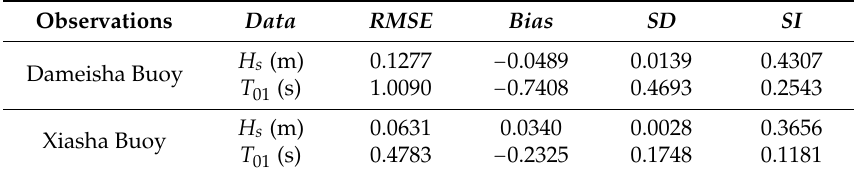
Table 8. Summary of the statistical errors for the simulations from 1 to 8 April 2014.